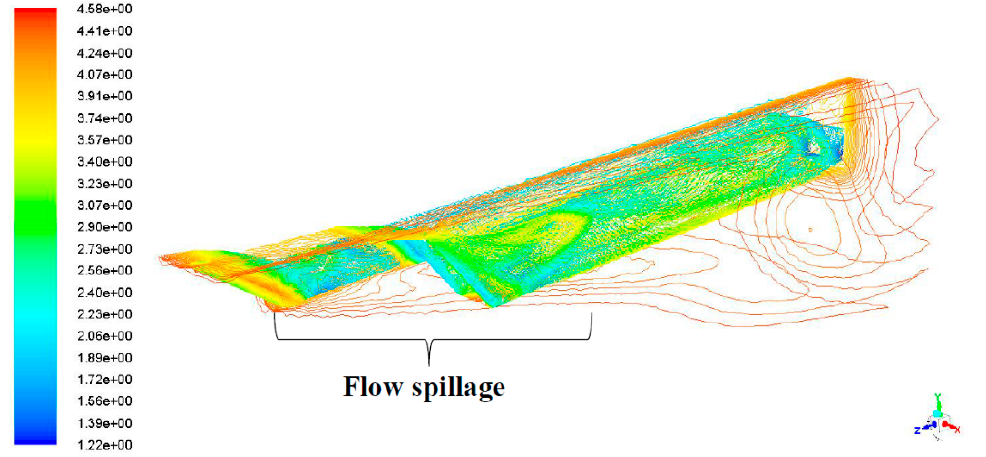
Figure 39. Oblique shock generated at scramjet wall at Mach 4.5.